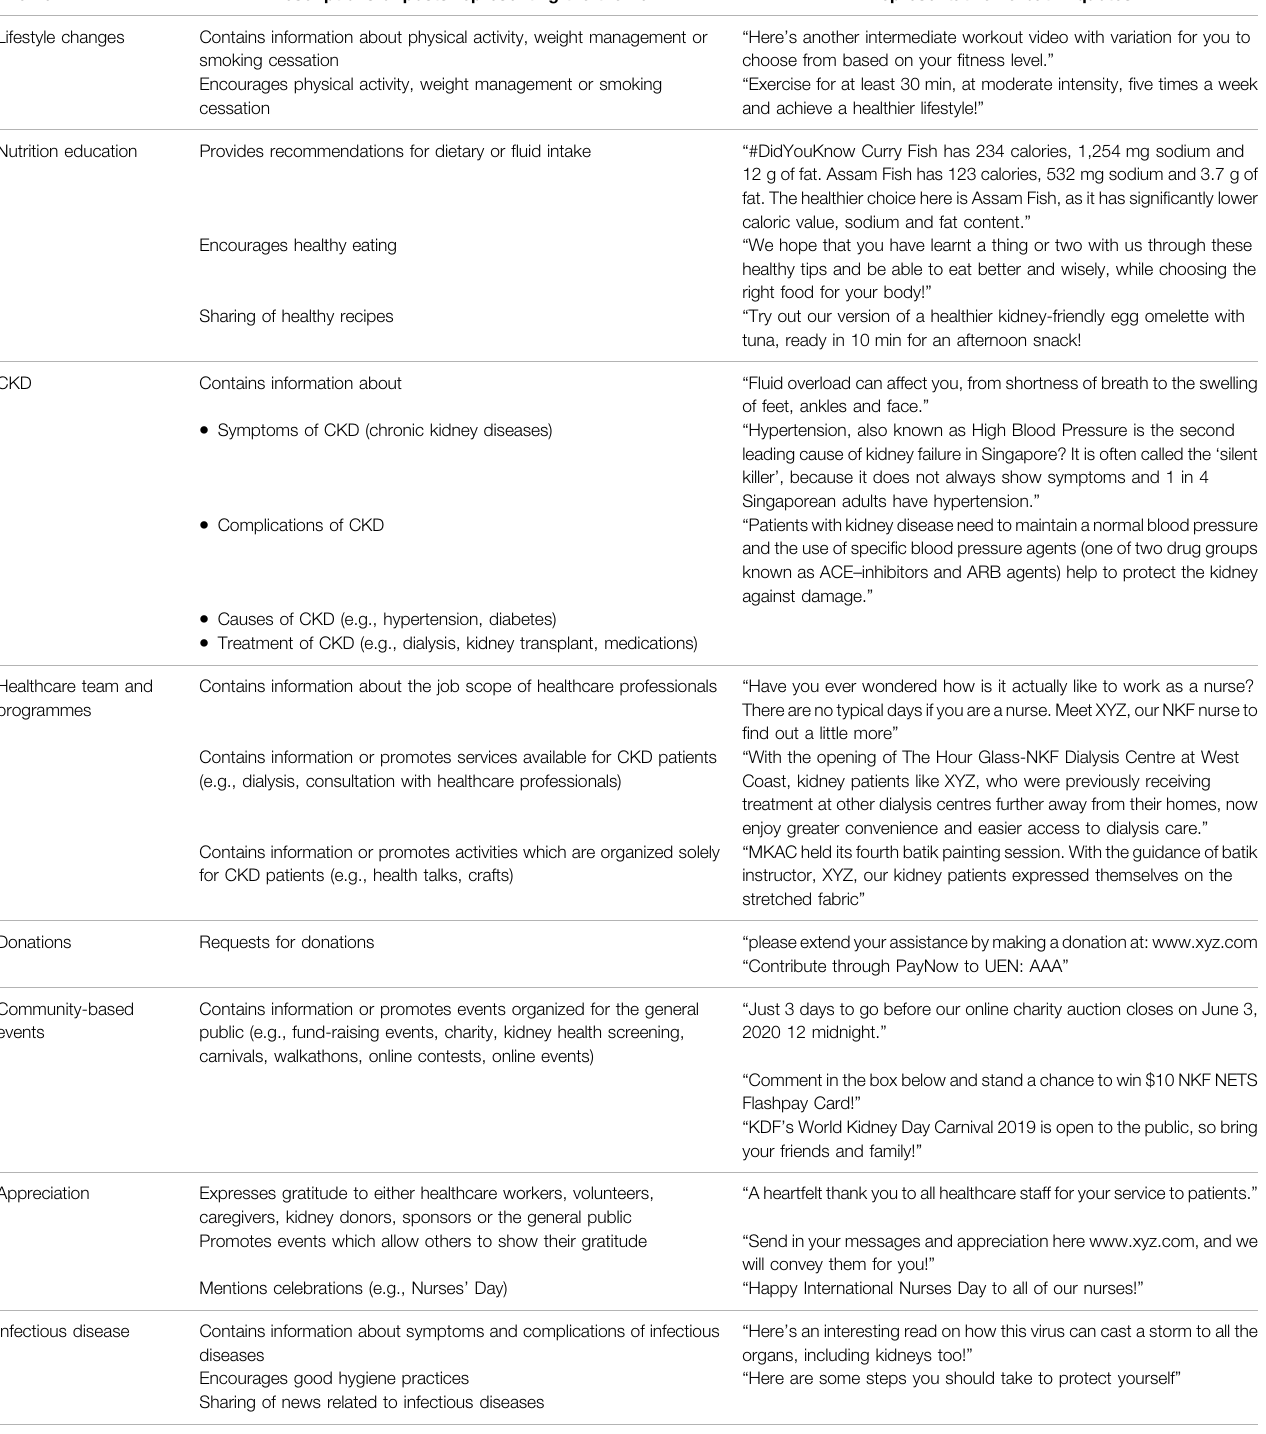
TABLE 1 | Descriptions of themes in the Facebook